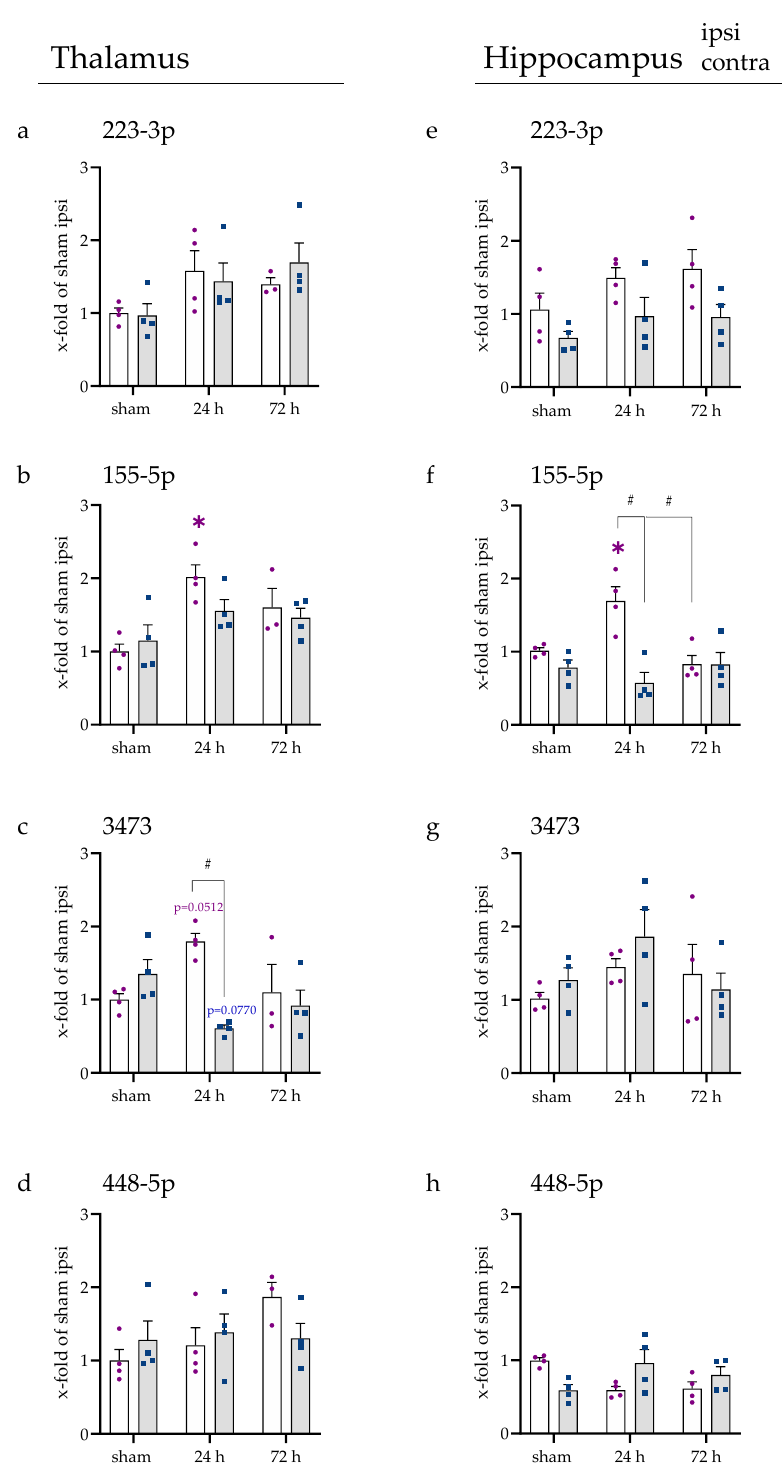
Figure 3. miRNA expression of thalamus and amygdala after 24 h and 72 h following tMCAo. ( a , e ) miRNA levels of miR-223-3p in thalamus and hippocampus, ( b , f ) miR-155-5p, ( c , g ) miR-3473, and ( d , h ) miR-448-5p. The graphs show the individual values for ipsi (purple) and contra (blue), and the mean in bars. Data were normalized to sham ipsi group and are pictured with the x-fold expression of this group ± SEM. (*) shows a significant difference between the ipsilateral side and sham ipsi. (#) comparison as